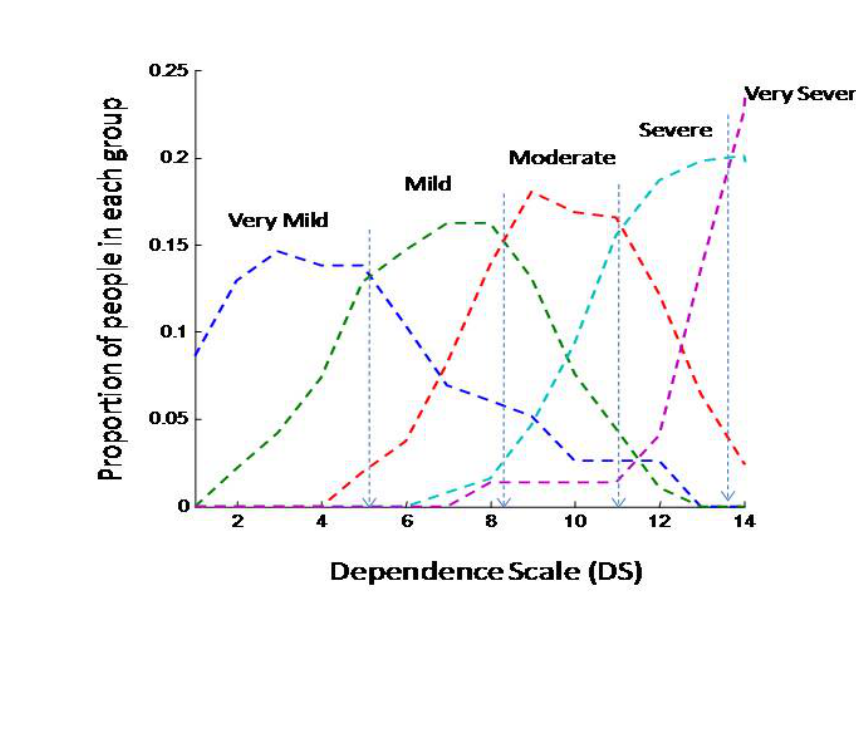
Figure 4. Probability distribution of the Dependence Scale score by dementia stage. Arrows indicate crossovers between the neighboring distributions and thus represent the the cut points to distinguish between the